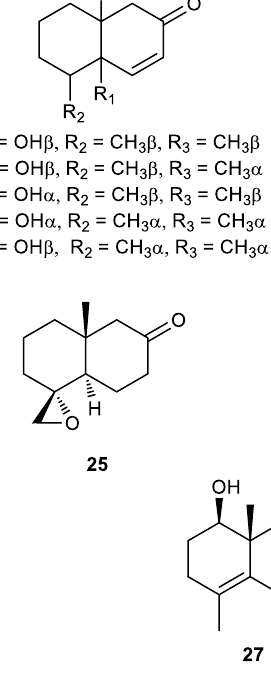
Figure 4. Some 11,12,13-tri- nor -eudemanes.